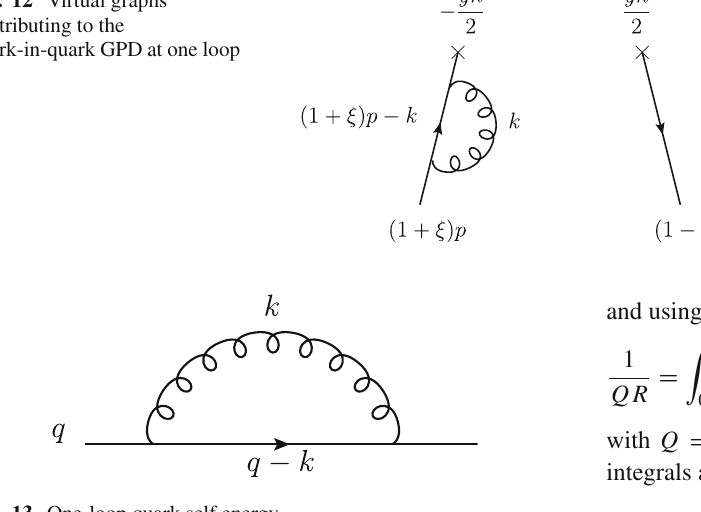
Fig. 12 Virtual graphs